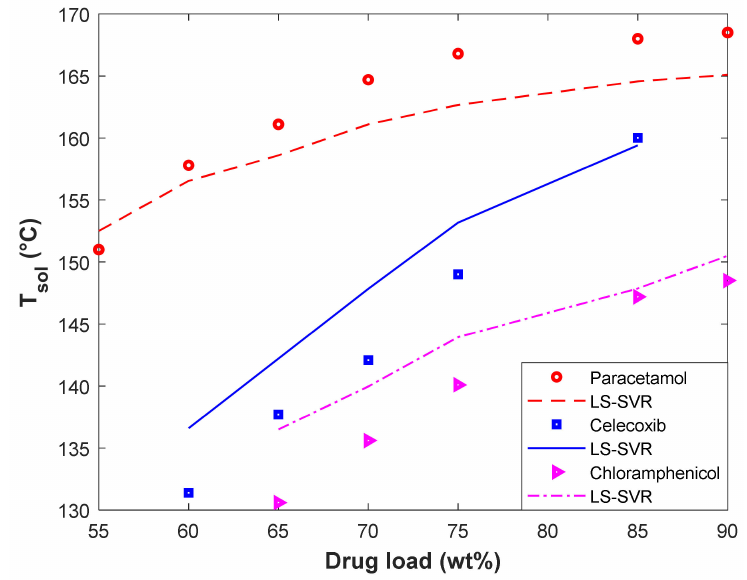
Figure 6. The effect of drug type and drug load in polyvinyl acetate on the solubility